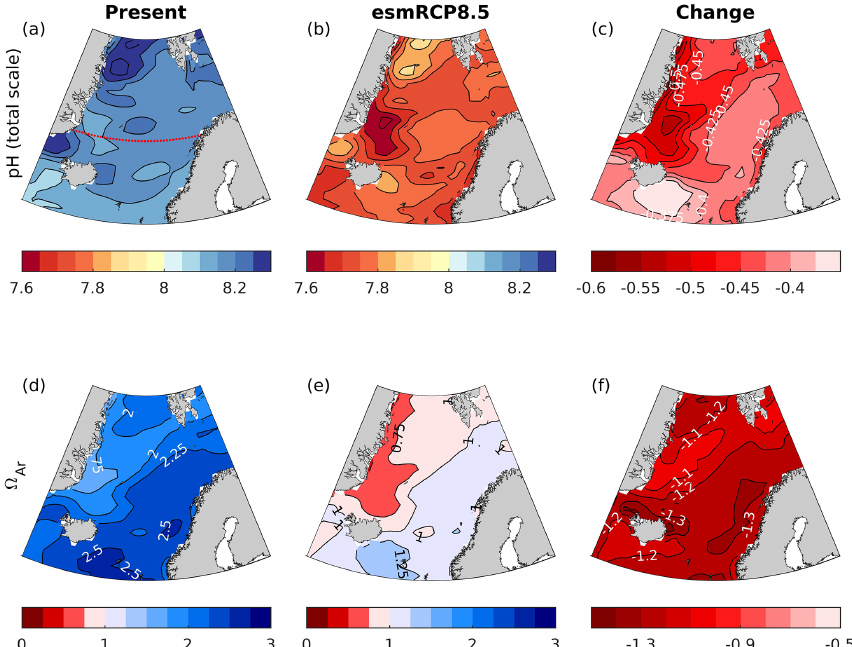
Figure 11. Maps of surface water (0m) pH and (cid:127) Ar for the present (1996–2005) and the esmRCP8.5 future (2090–2099), as well as the changes between the periods. The data input of the maps is based on GLODAPv2 gridded climatologies combined with the change from the NorESM1-ME. The dotted red line in panel (a) shows the location of the cross section presented in Fig.